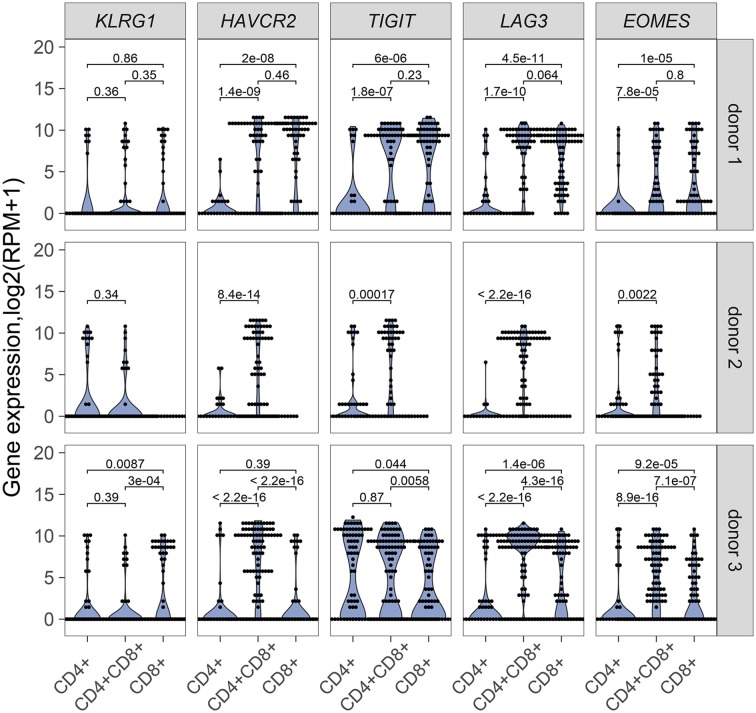
mRNA expression of inhibitory receptor genes KLRG1, HAVRC2, TIGIT, LAG3 and transcription factor gene EOMES in single CD4+, CD8+ and CD4+CD8+ DP T cells from donor 1 and donor 3 and in single CD4+ and CD4+CD8+ DP T cells from donor 2. Unpaired Wilcoxon test was used, p values are indicated on plots.